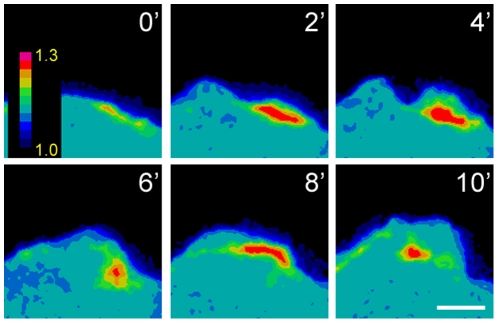
PKA is activated at the leading edge of migrating SKOV3 cells.SKOV-3 cells were transfected with pmAKAR3, plated onto fibronectin-coated dishes overnight, stimulated with 10 ng/ml EGF for 4-6 h, and then imaged by FRET microscopy. Images were captured every 30 sec, then pseudocolored according to FRET ratio (color scale shown in frame 0′): this montage depicts frames 2 min apart. For the whole sequence, see Video S1. Scale bar  = 5 µm.